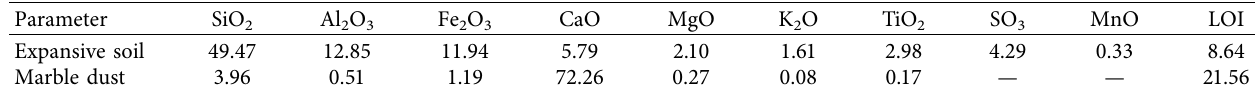
Table 2: Chemical analysis of the expansive soil and marble dust.